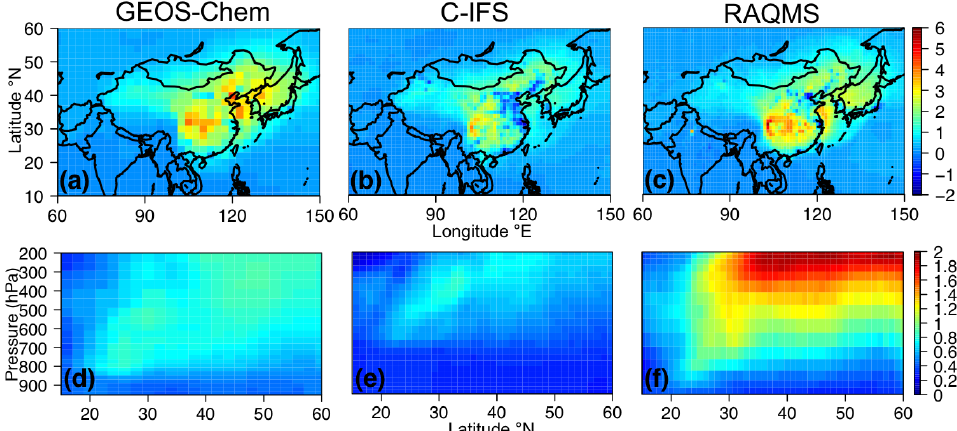
Figure 9. The monthly mean R (O 3 , EAS, 20%) in ppbv in June 2010 from the three boundary condition models at the source and near the receptor regions: (a–c) surface O 3 in East Asia; and (d) O x (GEOS-Chem) or (e–f) O 3 (ECMWF C-IFS and RAQMS) along the cross section of 135 ◦ W (near the west boundary of the STEM model domain as defined in Fig.